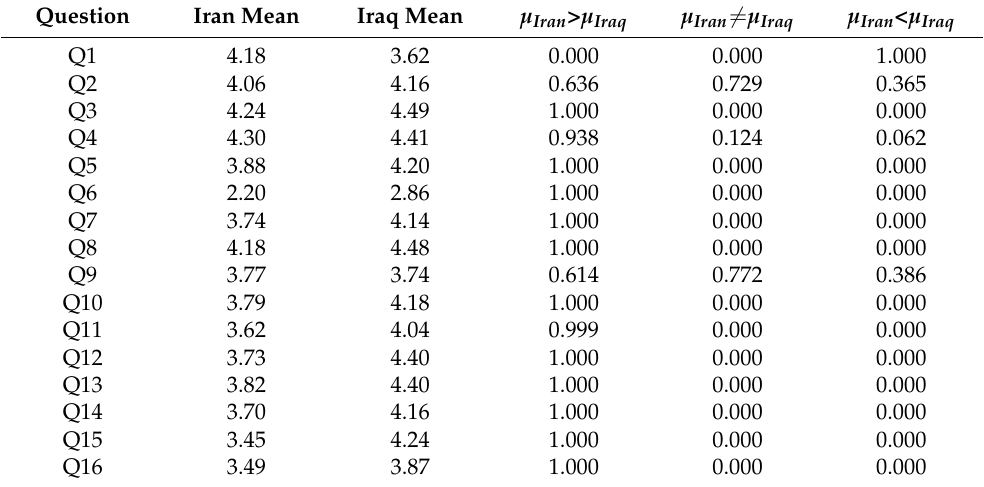
Table 6. The results of variance analysis of the mean of business ethics questions in Iran and